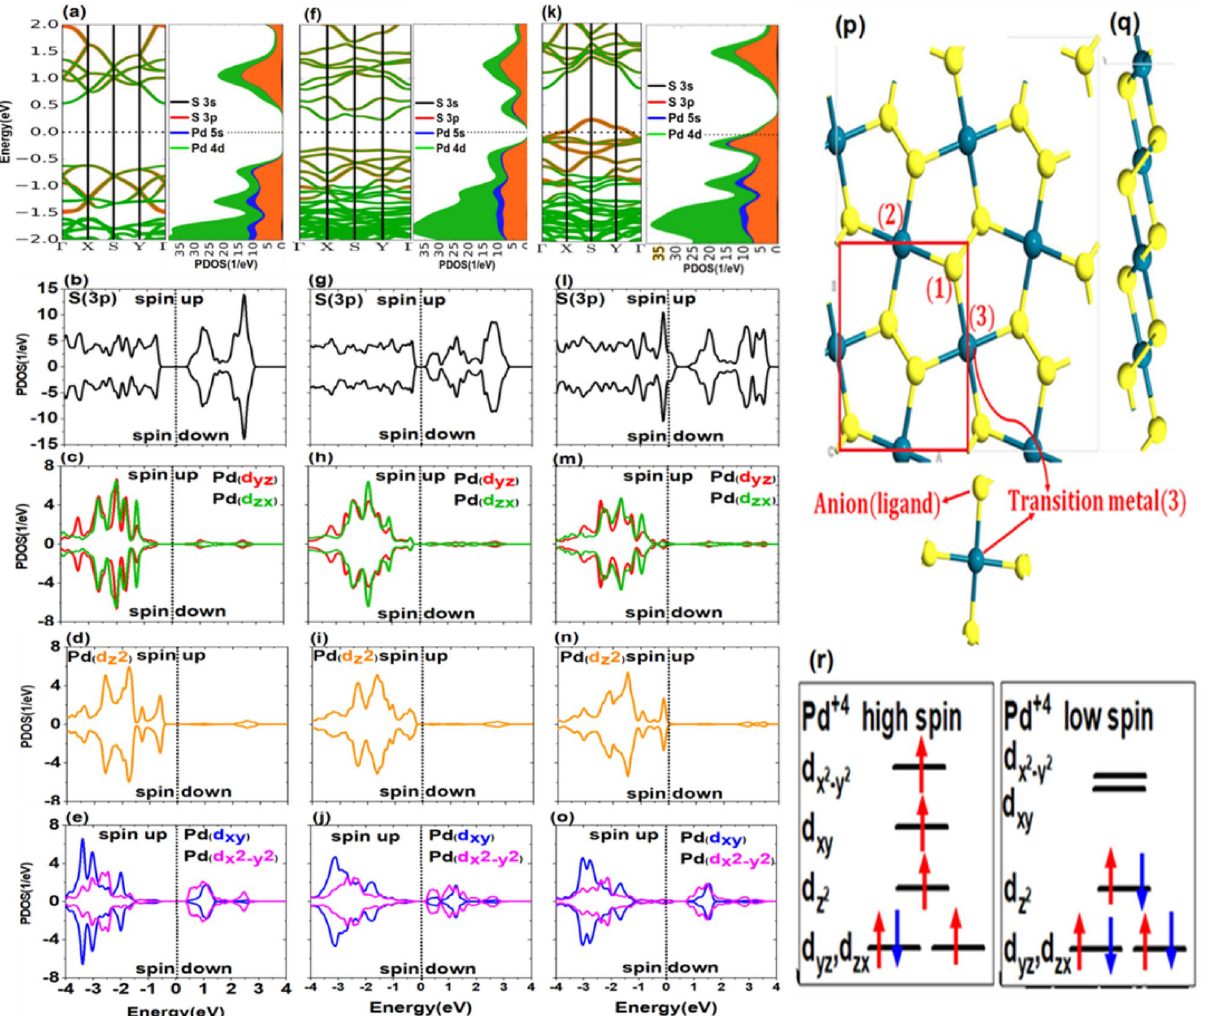
Figure 1. Band structure and density of states for 3p orbitals of S atom and 4d orbitals of Pd atom in Pd 2 S 4 structure: ( a – e ) without vacancy defect, ( f – j ) arising from defects in S atoms, ( k – o ) arising from defects in Pd atoms, ( p ) top view of Pd 2 S 4 structure with the position of vacancy defect for S (No. 1) and Pd (No. 2) atoms, ( q ) side view of Pd 2 S 4 structure, and ( r ) electrons located in 4d orbitals of Pd +4 cation in strong and weak crystal